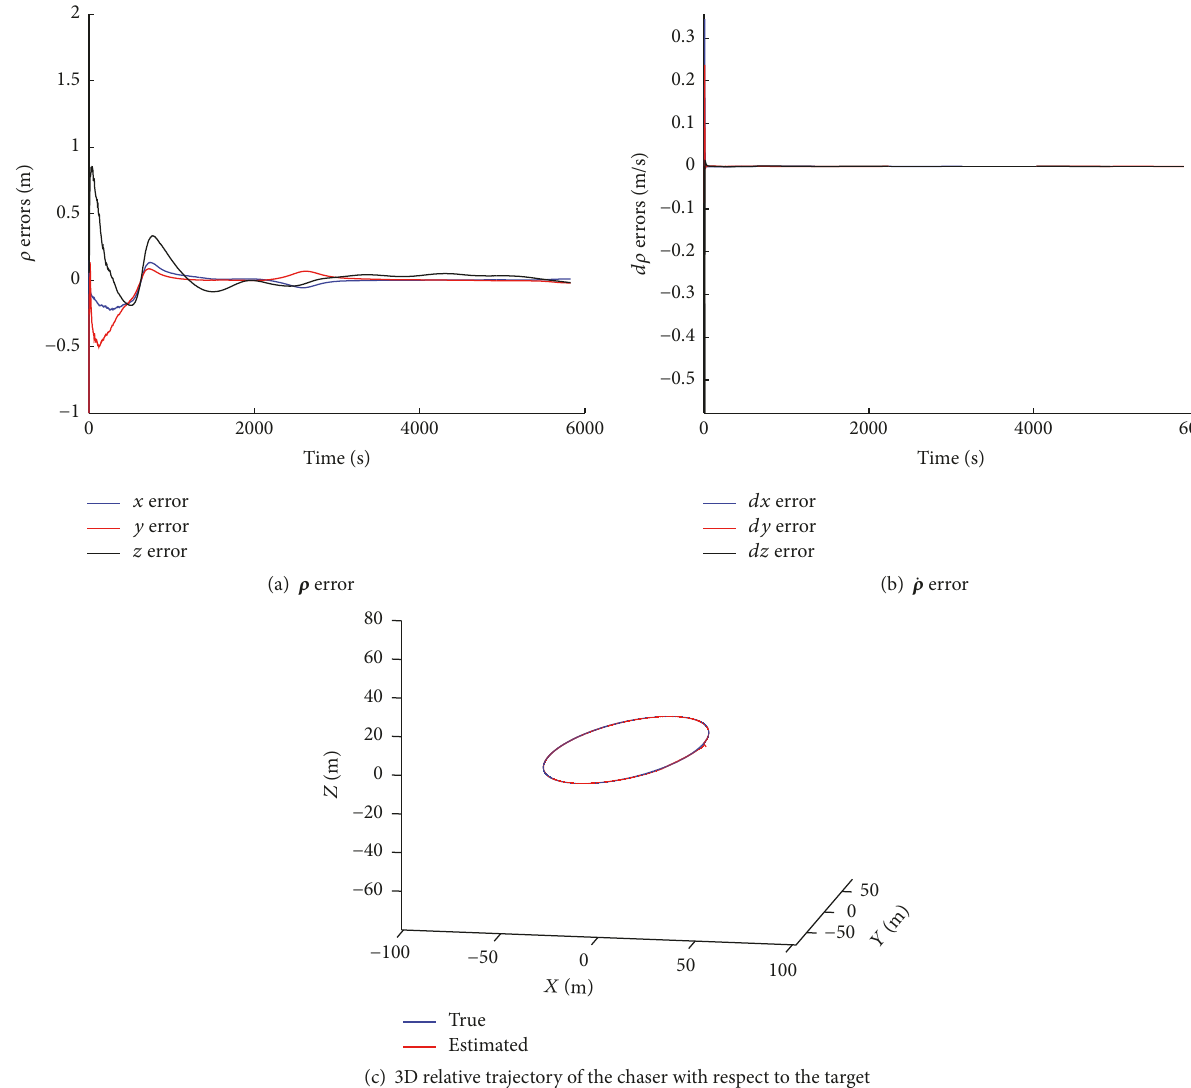
̇̂ 𝜌 (m/s). (c) True versus